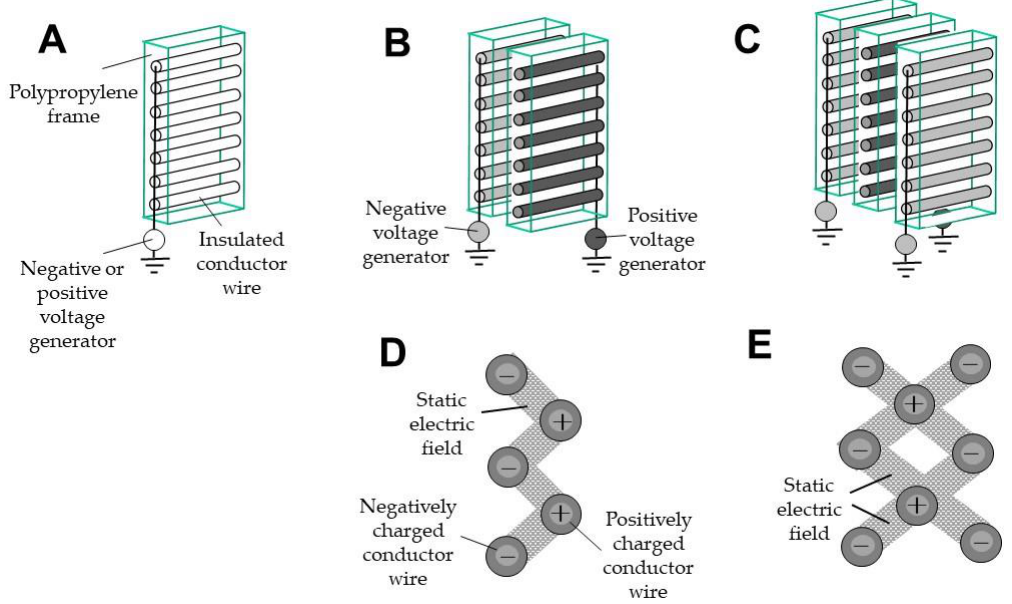
Figure 6. ( A ) Single-charged monopolar electric field screen; (B, C) double-charged dipolar electric field screens (DD screens) constructed with ( B ) two and ( C ) three layers; ( D , E ) static electric fields formed between oppositely charged conductor wires of ( D ) two-layer and ( E ) three-layer screens (cross-sectional view).